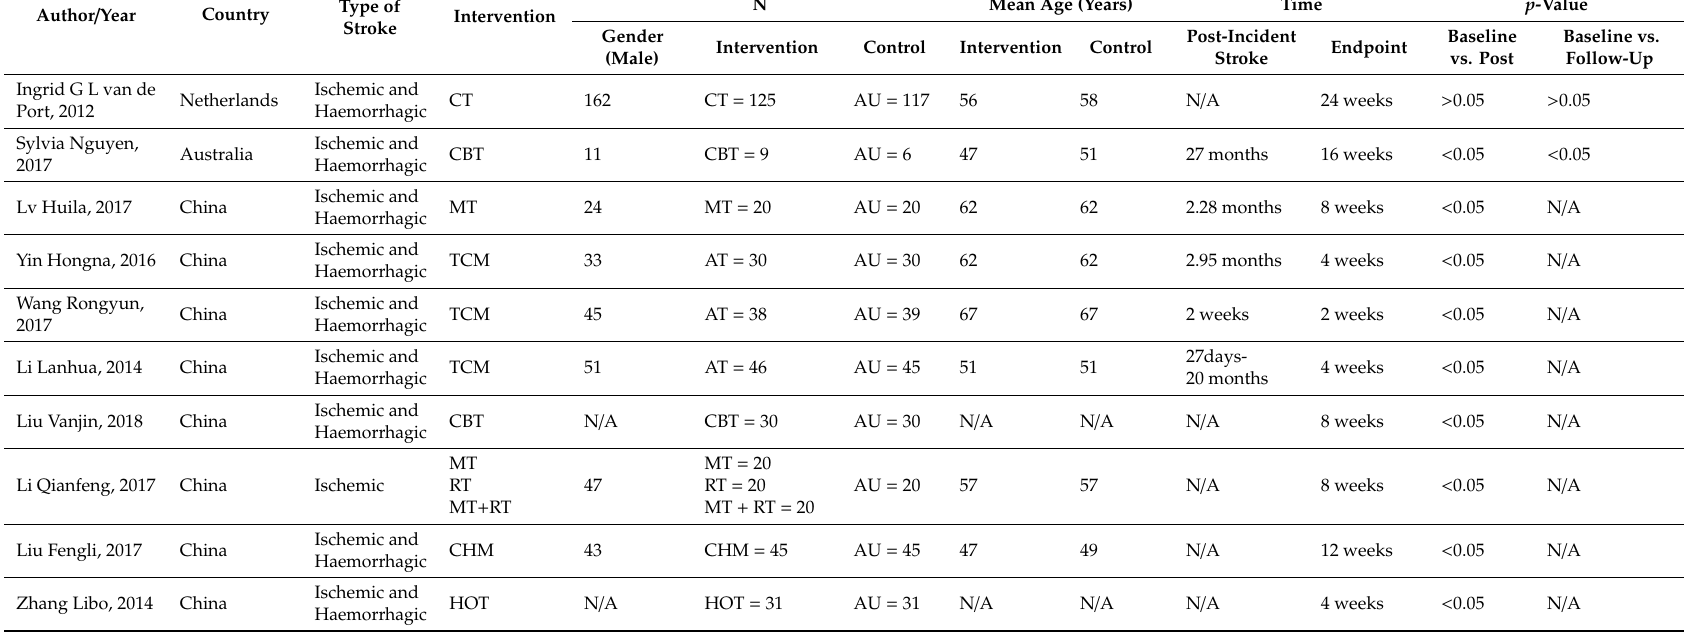
Table A2. Characteristics of all involved